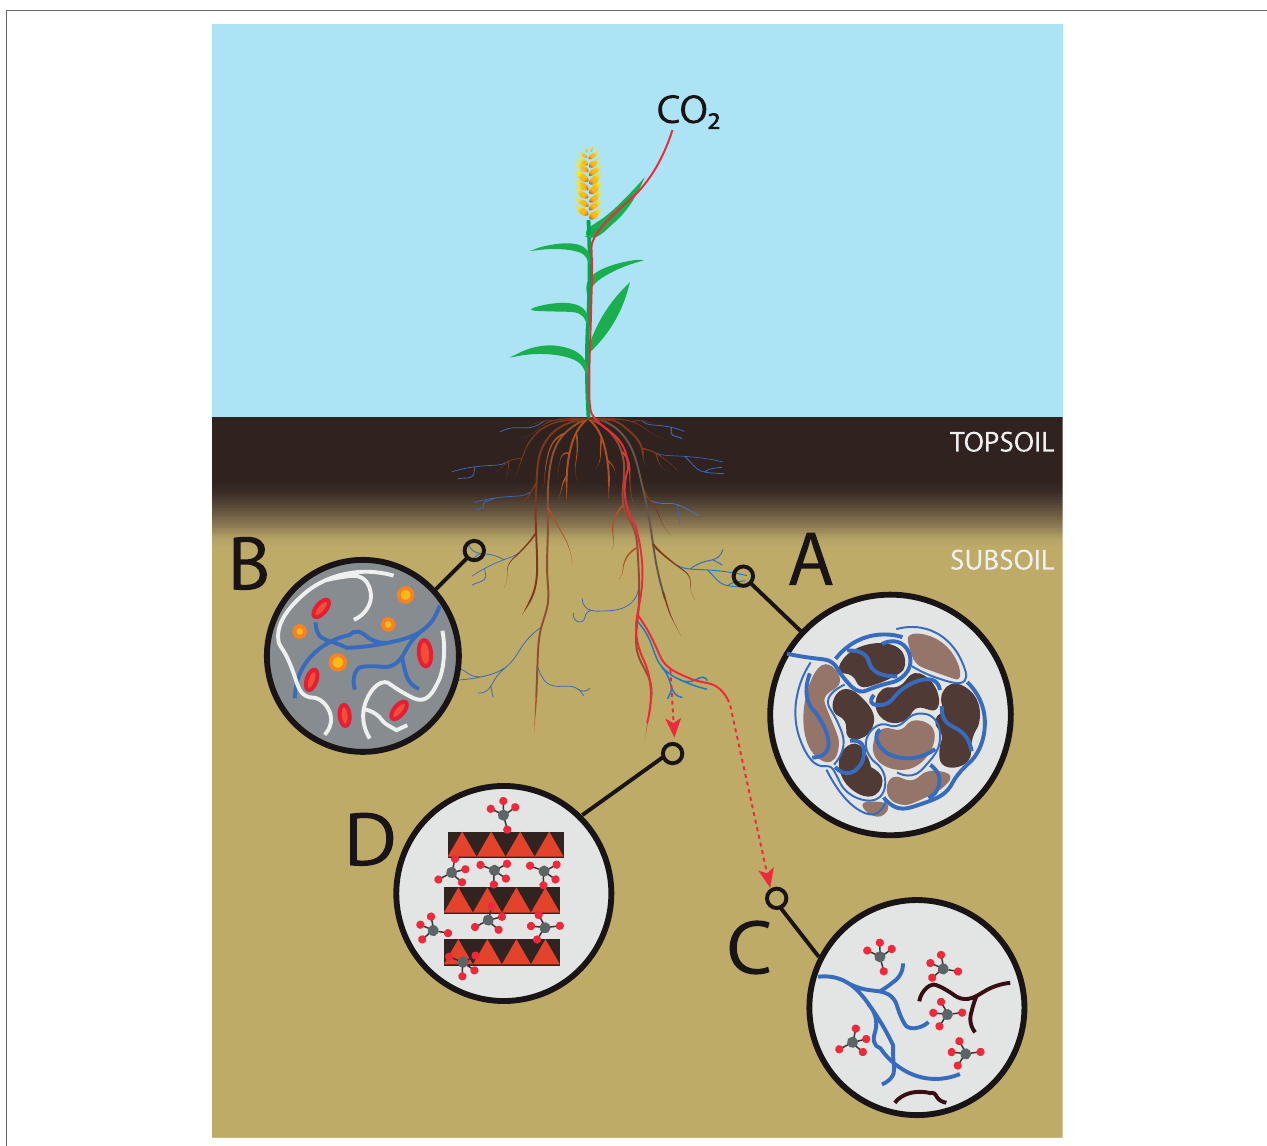
FIGURE 2 | Subsoil AM fungi and carbon farming. Overview of different benefits of subsoil AM fungi on carbon sequestration. (A) Improvement of the soil structure, leading to aggregate-protected organic matter. (B) Competition with saprotrophic bacteria and fungi, thus reducing decomposition rates. (C) Increased carbon input in subsoil via mycelial exudates and turnover. (D) Formation of highly stable mineral-associated organic matter